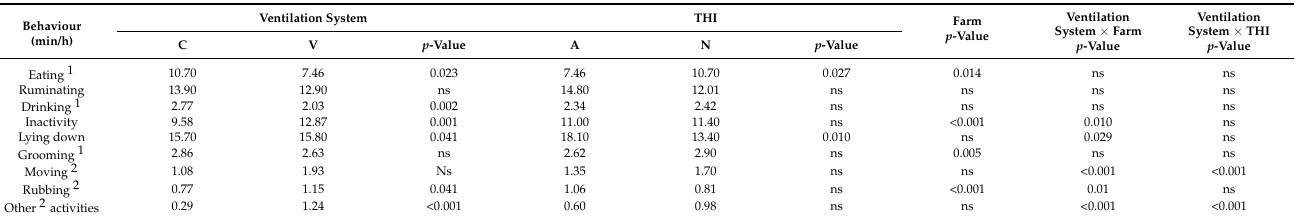
Table 2. Effect of ventilation system treatment, temperature humidity index (THI) condition, farm and their interaction on young bulls’ behaviour expressed as